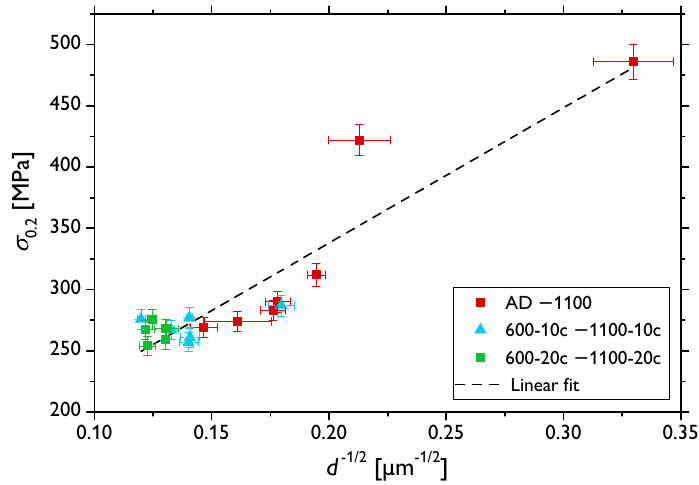
Figure 7. The Hall–Petch plot for all the investigated samples sets—initial sample, annealed samples, and thermally-cycled